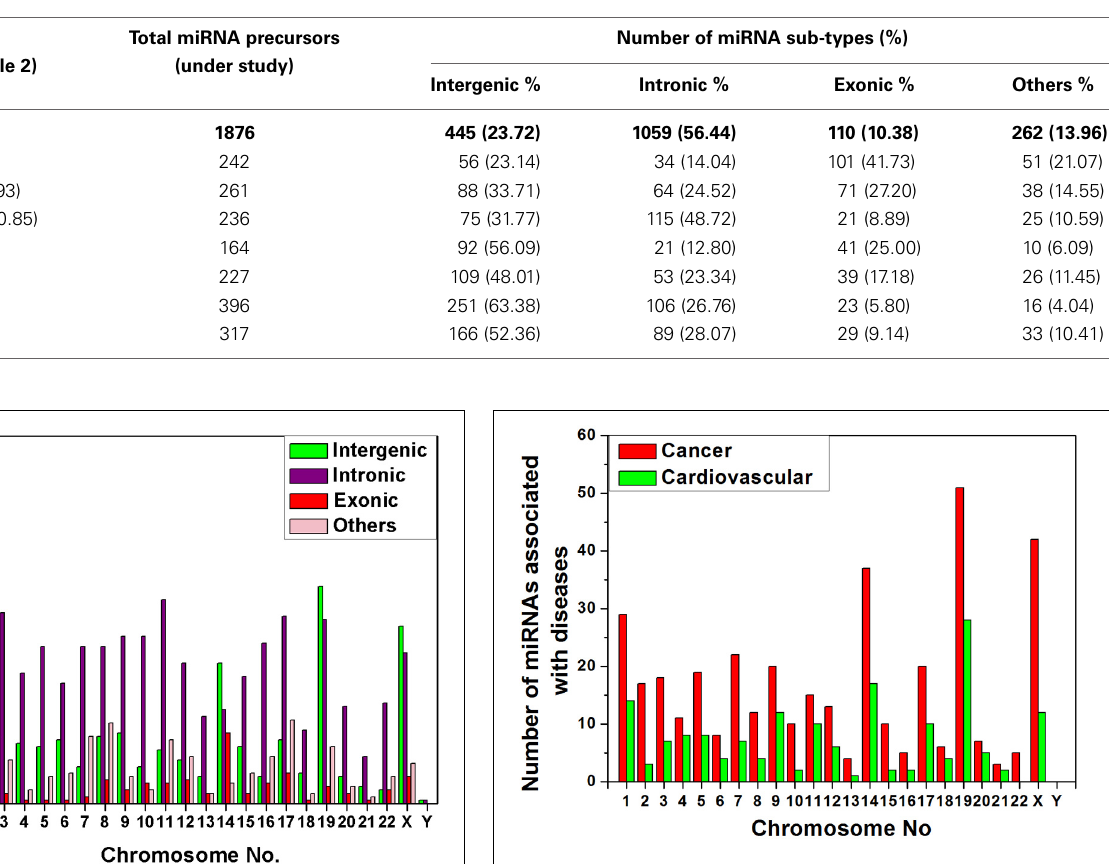
Table 3 | Number of miRNA sub-types in different species.